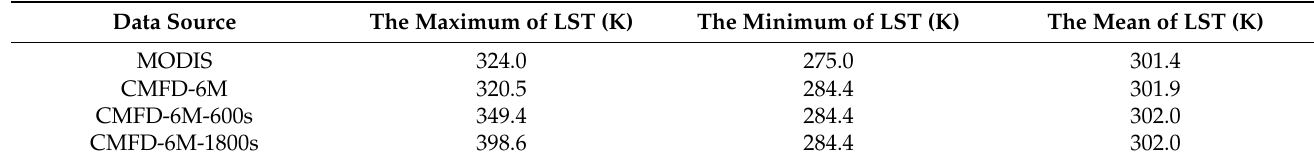
Table 4. The results of cases with different model time step sizes compared with MODIS LST. Data Source The Maximum of LST (K)